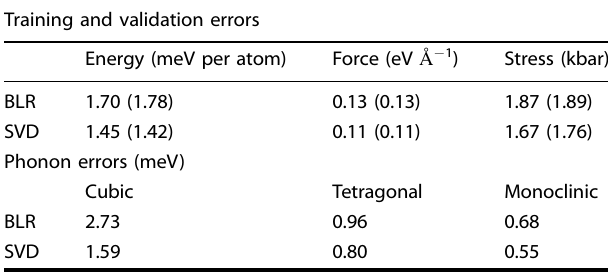
Table 1. RMSE in the energies, forces, and stress tensors predicted by the MLFF for the training and test dataset and RMSE in the predicted phonon energies for each phase. Training and validation errors